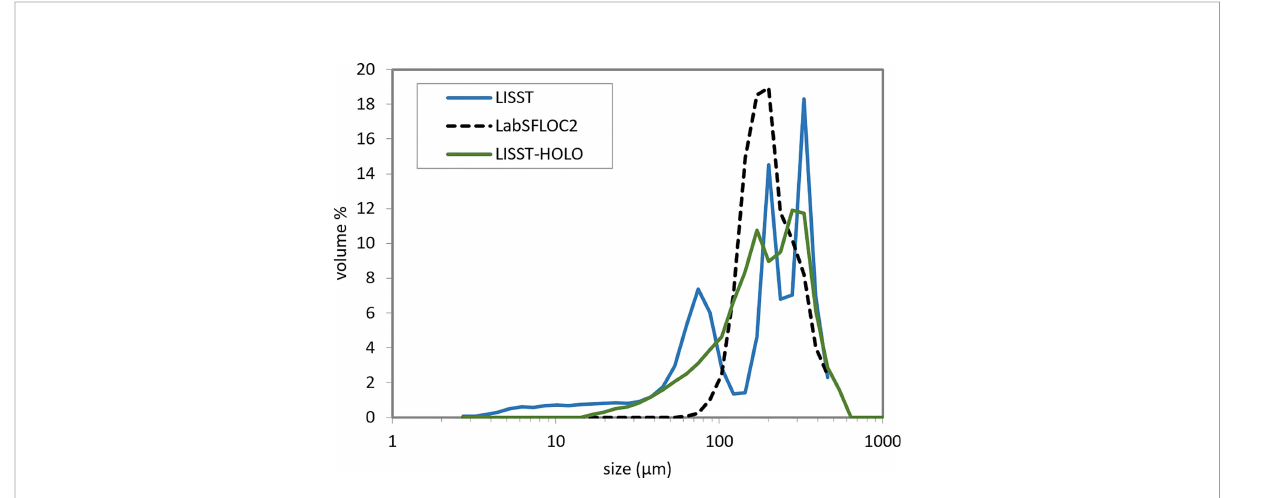
FIGURE 5 Comparison between the PSD ’ s obtained from three measurement techniques. Each PSD is the average of the data collected during the 11 hour